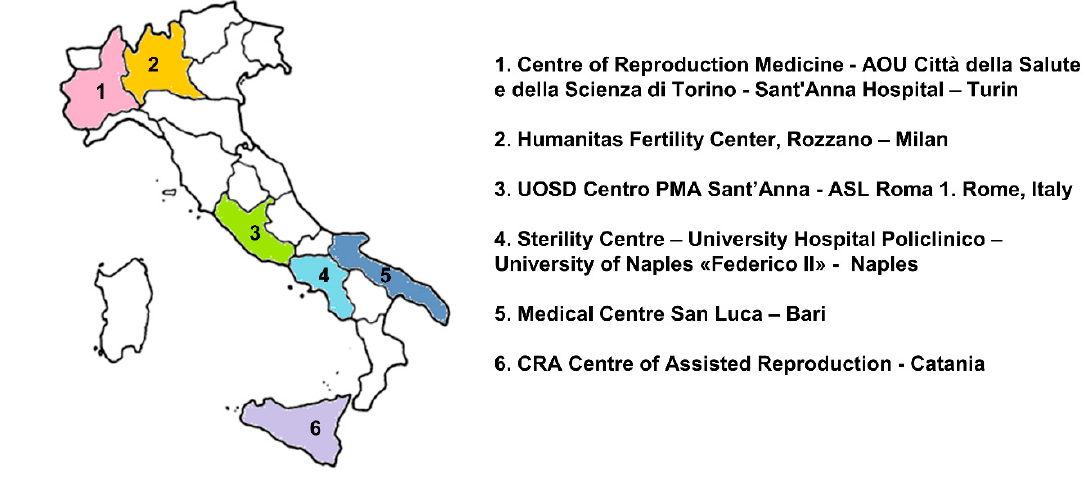
Figure 1. Recruiting centers.